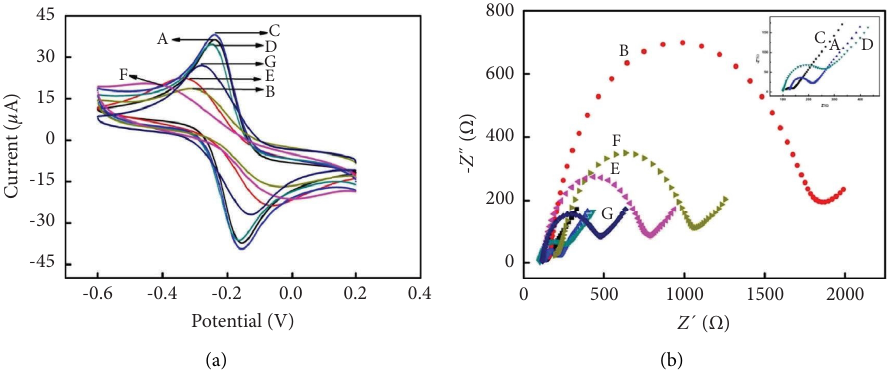
Figure 2: (a) CVs and (b) EIS of (A) bare GCE, (B) L-Cys/GCE, (C) AuPt NFs/L-Cys/GCE, (D) Ab1/AuPt NFs/L-Cys/GCE, (E) BSA/Ab1/ AuPt NFs/L-Cys/GCE, (F) Ag/BSA/Ab1/AuPt NFs/L-Cys/GCE, (G) Bioconjugates/Ag/BSA/Ab1/AuPt NFs/L-Cys/GCE in [Fe(CN) 6 ] 3-/4-